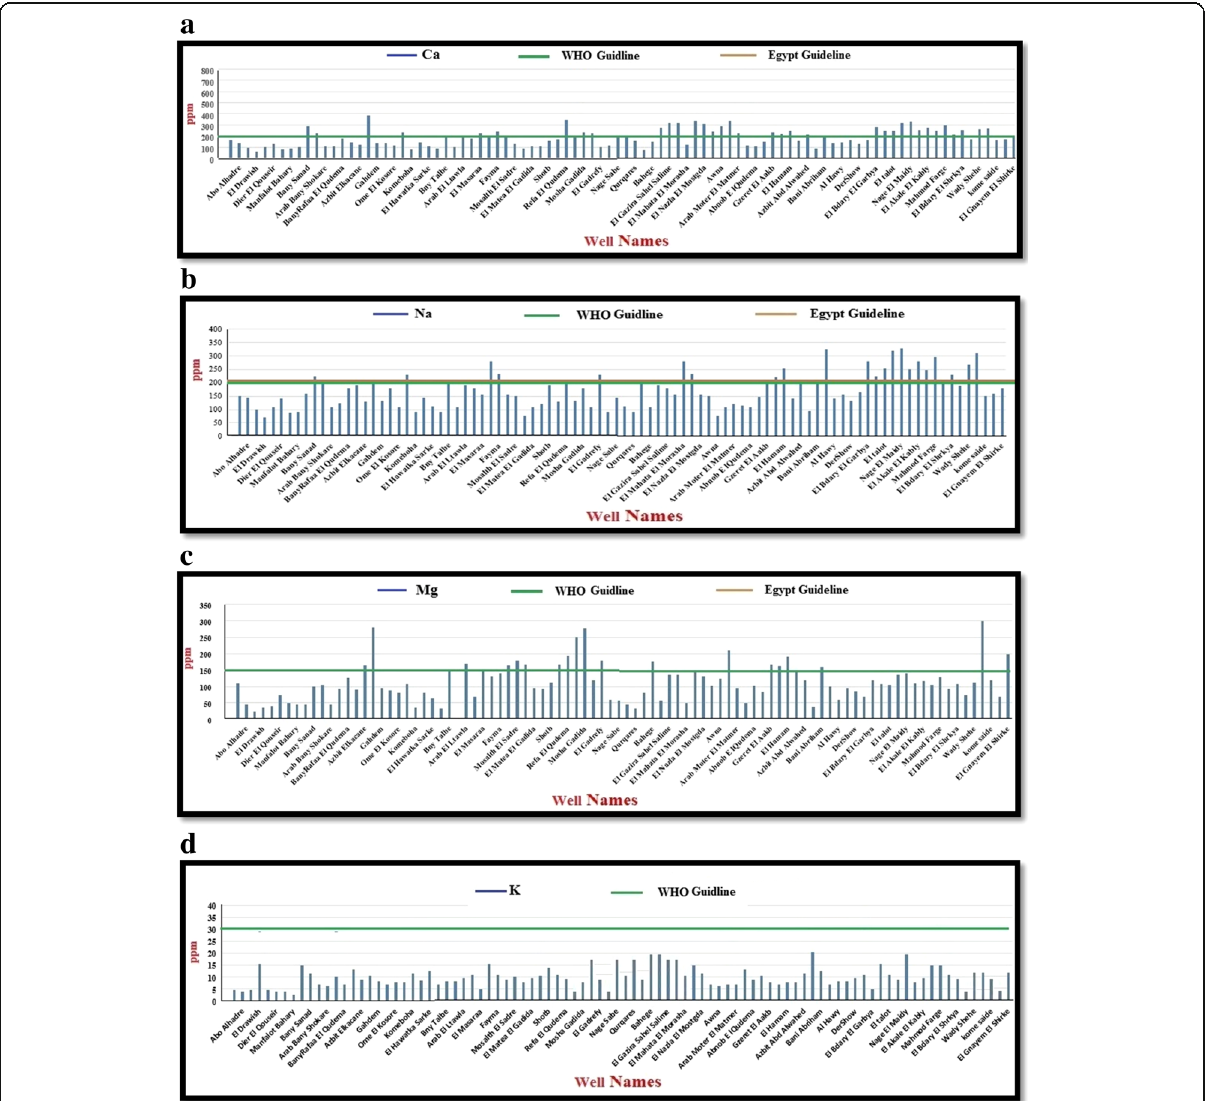
Fig. 9 a Ca, b Mg, c Na, and d K concentration of groundwater samples compared with WHO Guidelines (2004) and Egyptian Higher Committee for Water (2007) guidelines for drinking